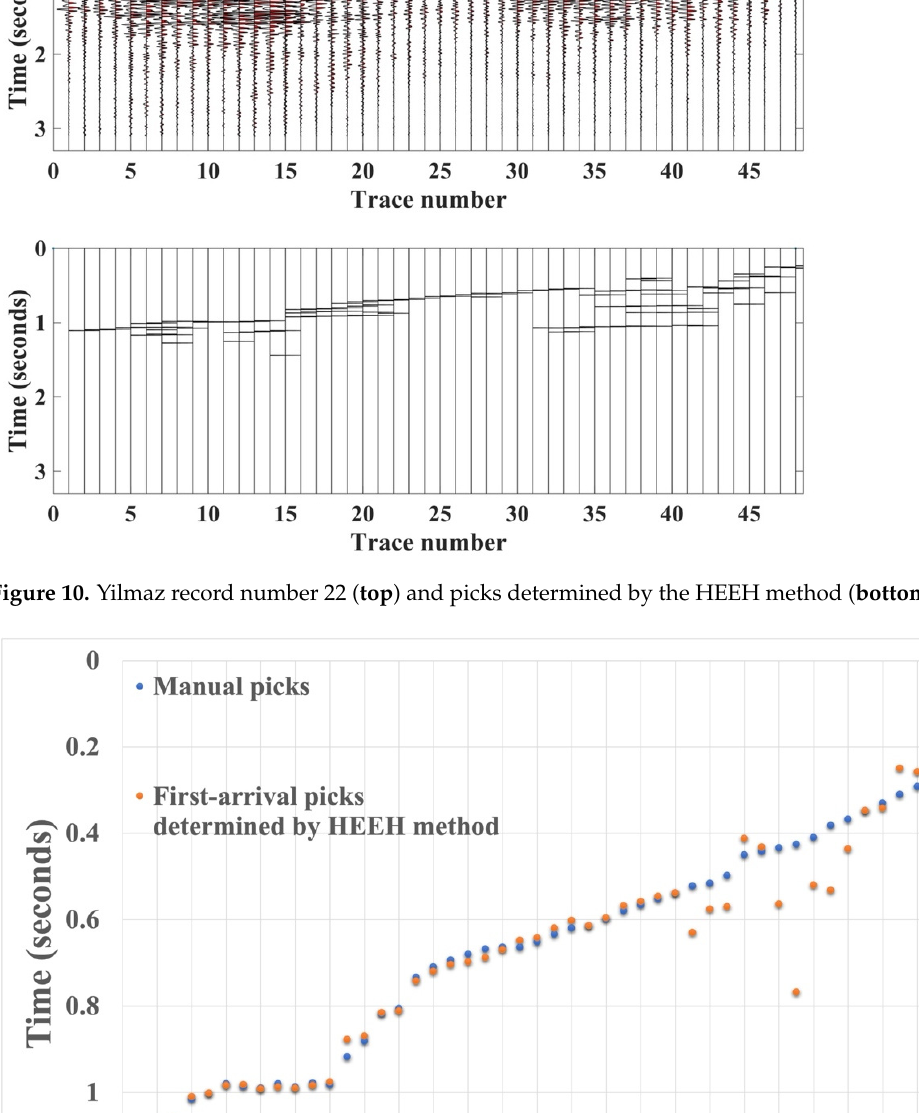
Table 3. The percentage of the number of HEEH picks within 20 ms for the real dataset.